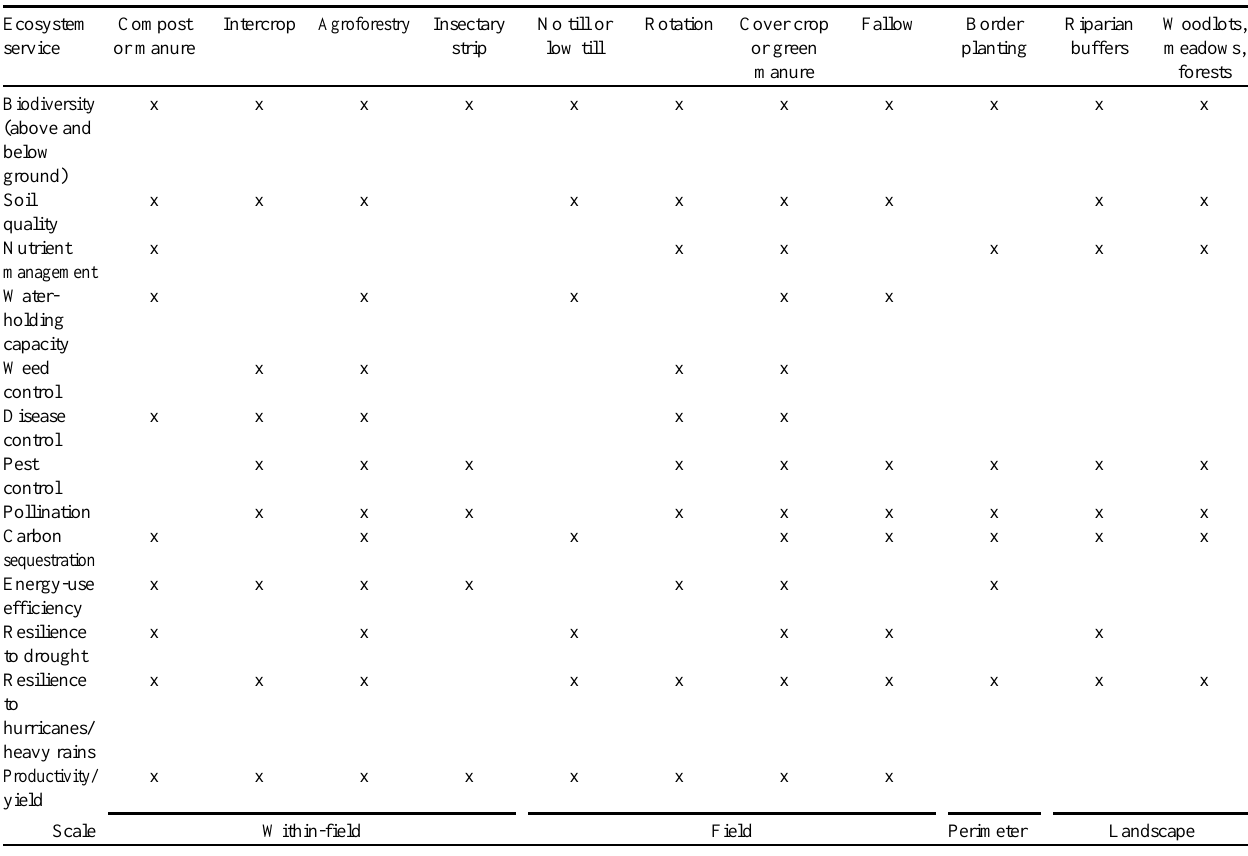
Within-field Field Perimeter